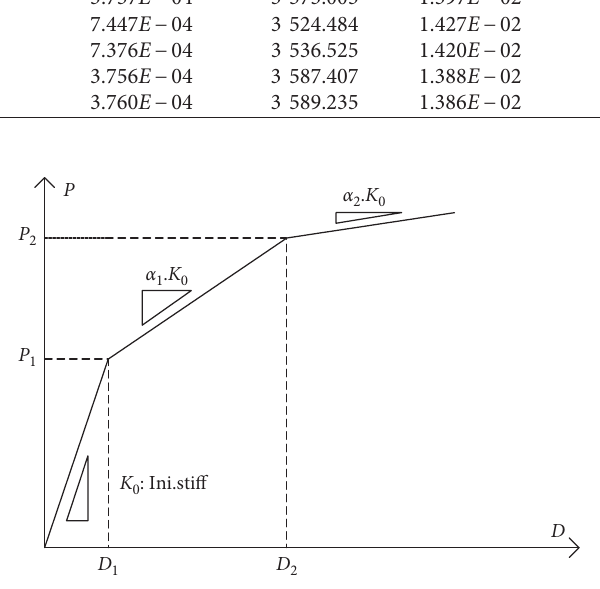
Figure 27: Three-fold line model of moment-curvature constitutive relationship. Table 18: Stiffness and reduction factor of rectangular piles.